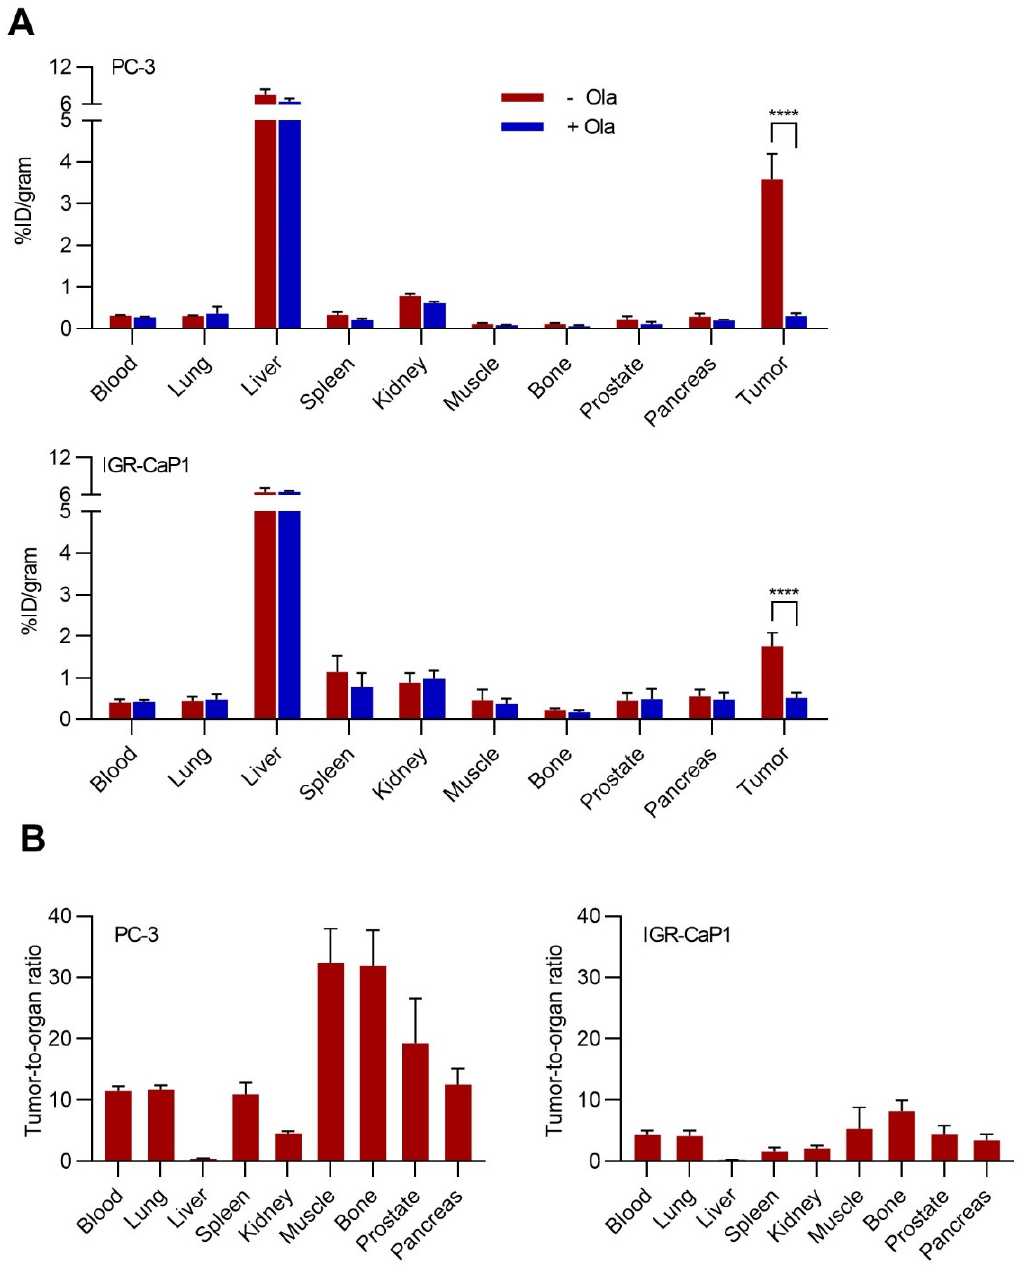
Figure 4. ( A ), biodistribution of [ 77 Br]Br-WC-DZ (370 kBq) at 4h (+/ − 5 mg/kg bwt olaparib block) in athymic nude mice (n = 5) bearing PC-3 and IGR-CaP1 tumors. The data represent the mean ± SD. **** p < 0.0001 ( B ), tumor-to-organ ratios of uptake of [ 77 Br]Br-WC-DZ (370 kBq) at 4h in PC-3 ad IGR-CaP1 tumors and selected organs of tumor-bearing mice.